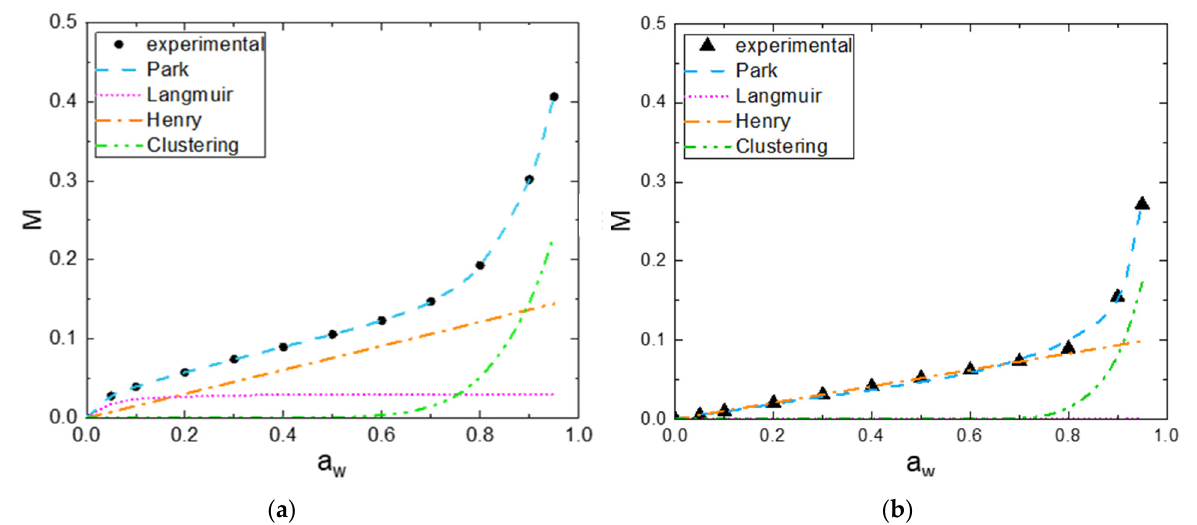
Figure 6 . Experimental results and Park fit of experimental sorption isotherms for ( a ) V fiber and ( b ) CA fiber .